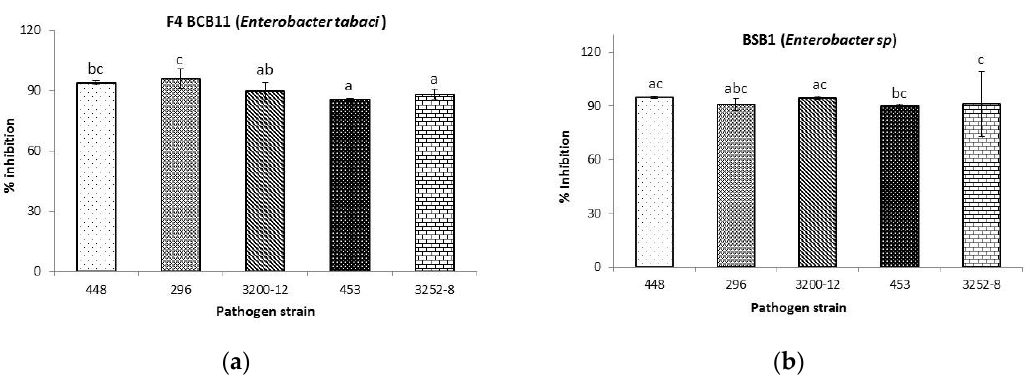
Figure 3. Growth inhibition of different B. glumae strains. ( a ) Fraction F4 BCB11 ( Enterobacter tabaci ( E. tabaci )) inhibitory activity. ( b ) Inhibitory activity of total EtOAc extract from Enterobacter sp. fermentation. Different letters indicate significant differences ( p < 0.05), following Duncan’s multiple range test.